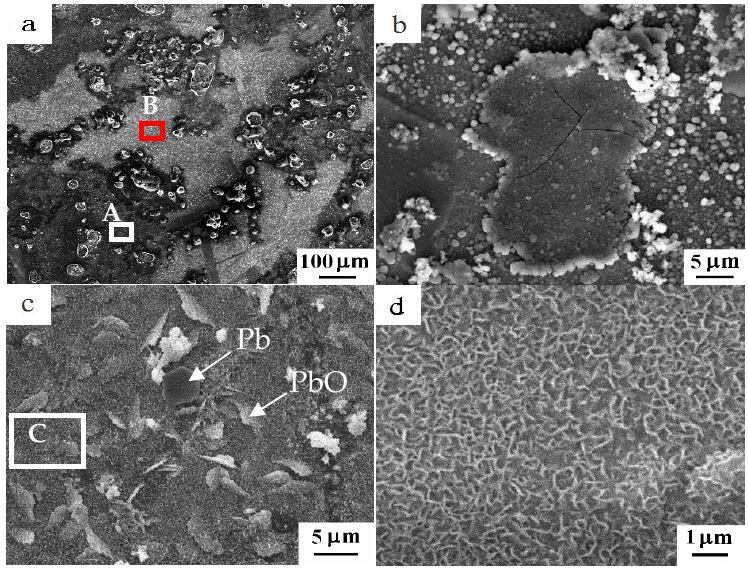
Figure 9. ( a ) Surface layer of the reacted FeSiB AR and ( b , c ) enlarged views of the corresponding region A and B in ( a ), respectively. ( d ) Enlarged view of the corresponding region C in ( c ).